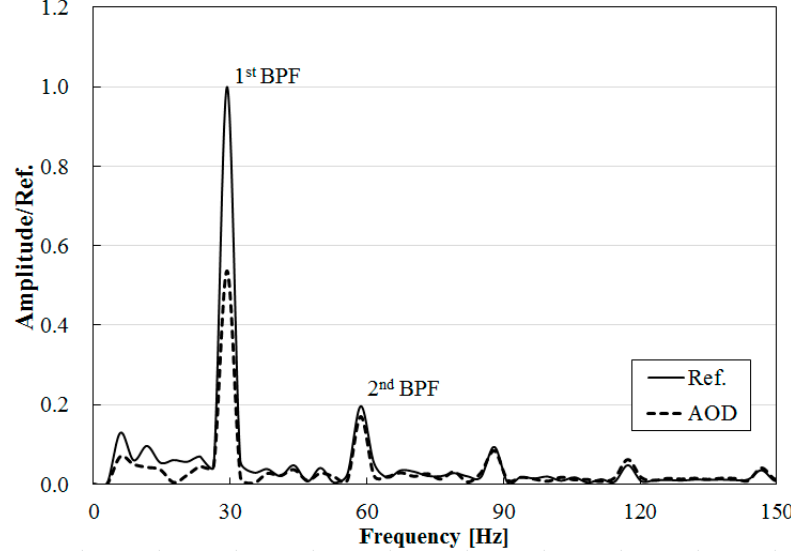
Figure 18. Spectra of amplitude values on casing wall near the tongue of volute.